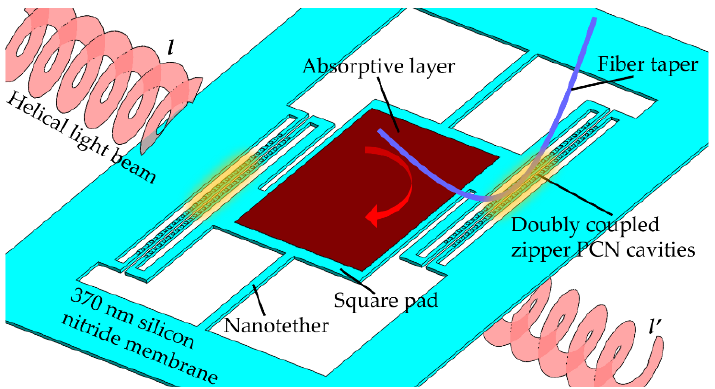
Figure 27. Optomechanical orbital angular momentum (OAM) sensor using a pair of zipper cavities [148].